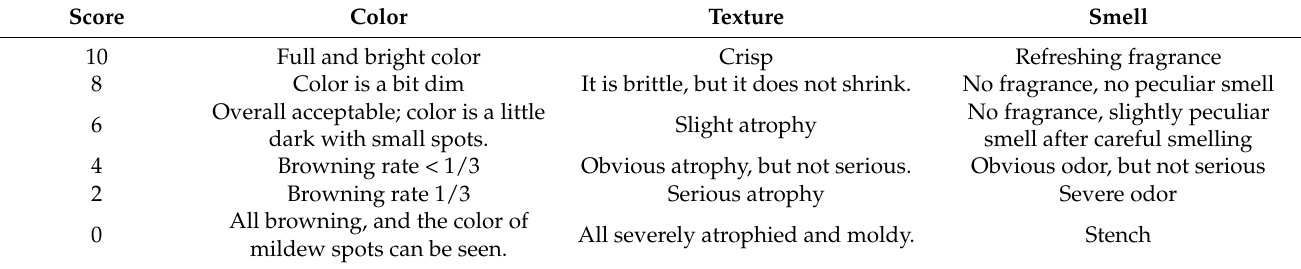
Table 2. Sensory-evaluation